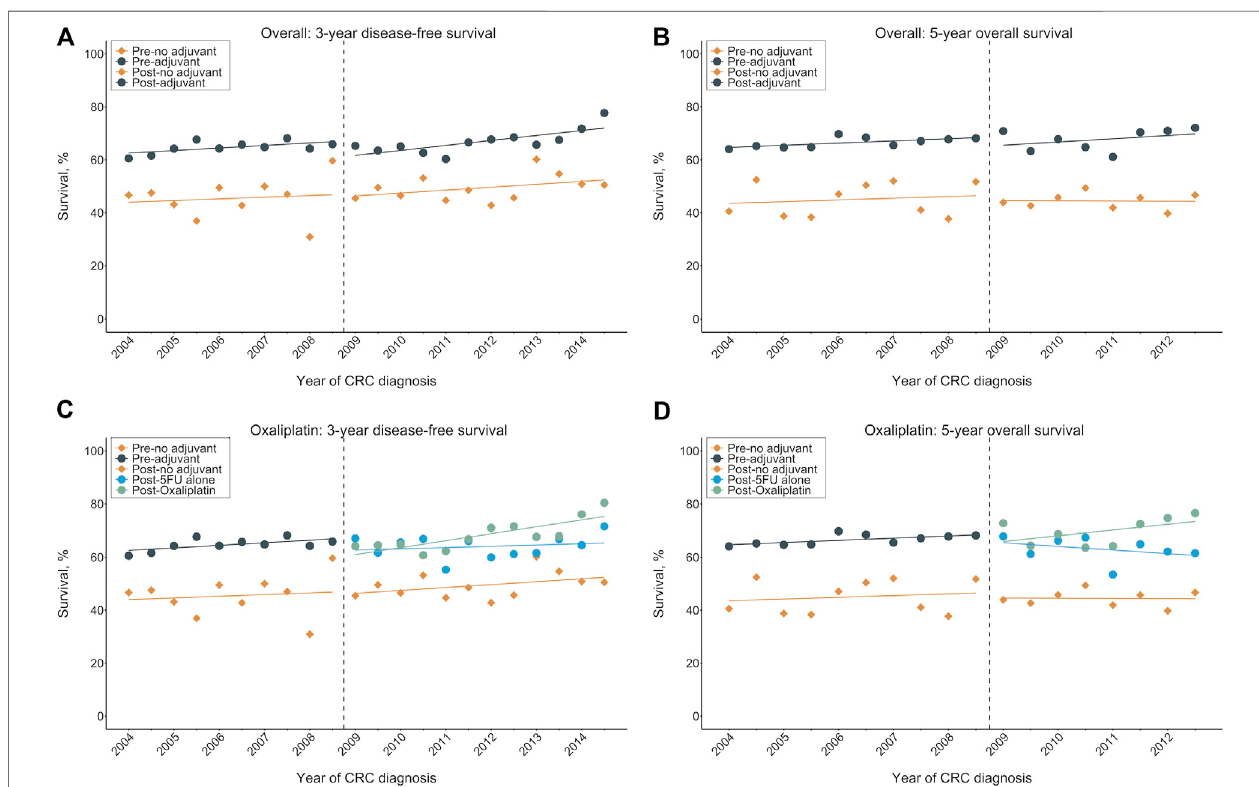
FIGURE1| Survivaloutcomesbycalendaryearbeforeandafteroxaliplatinreimbursementintheentirepopulation. (A) Three-yearDFSratesforoverallcohorts, (B) Five-year OS rates for overall cohorts, (C) Three-year DFS rates for oxaliplatin cohort, (D) Five-year OS rates for oxaliplatin cohort. The vertical broken lines delineate the intervention time [between quarter 4 (Q4) 2008 and Q1 2009]. DFS: disease-free survival; OS: overall survival.